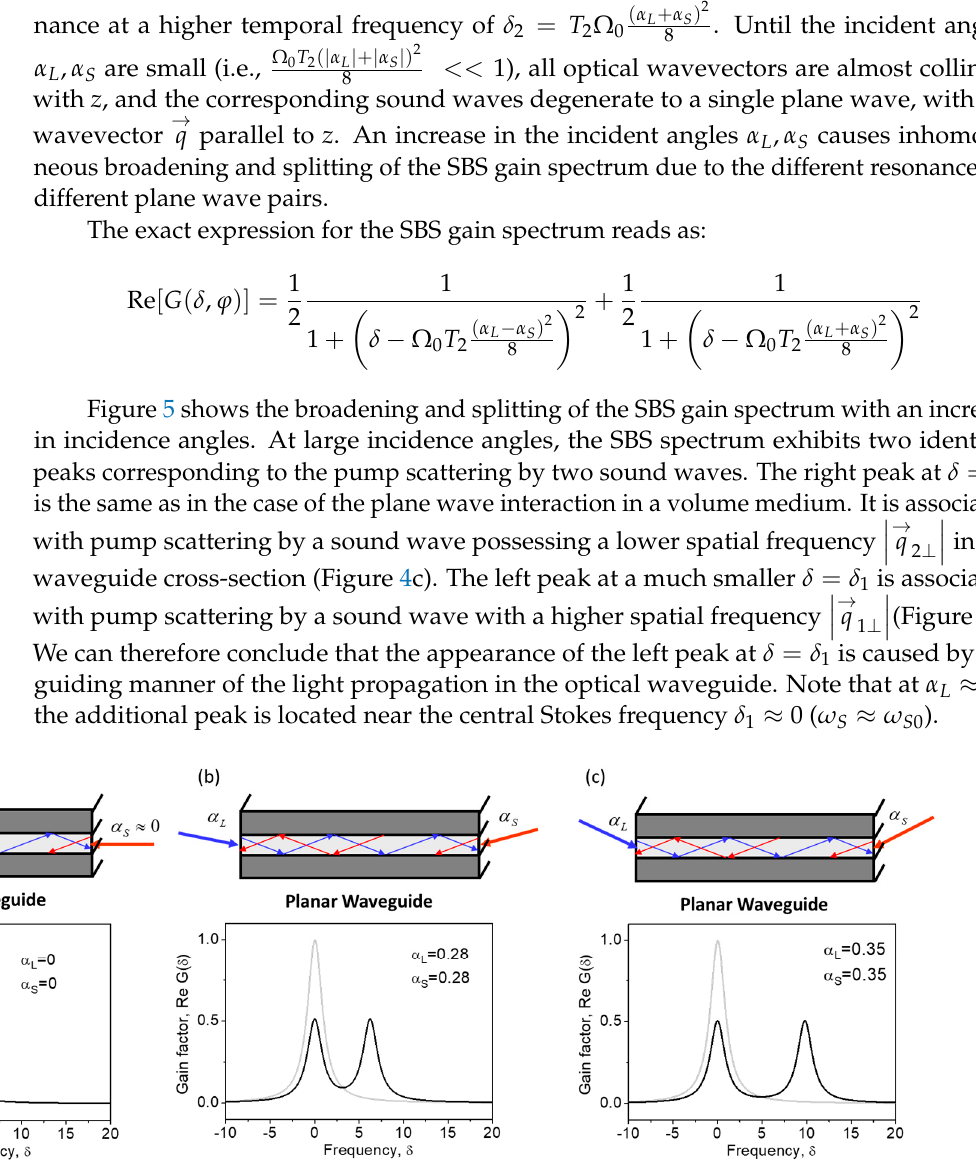
Figure 5. Brillouin gain spectra for the interaction between eigenmodes of different orders ( a – c ) in a planar waveguide. Calculations are performed using Equation